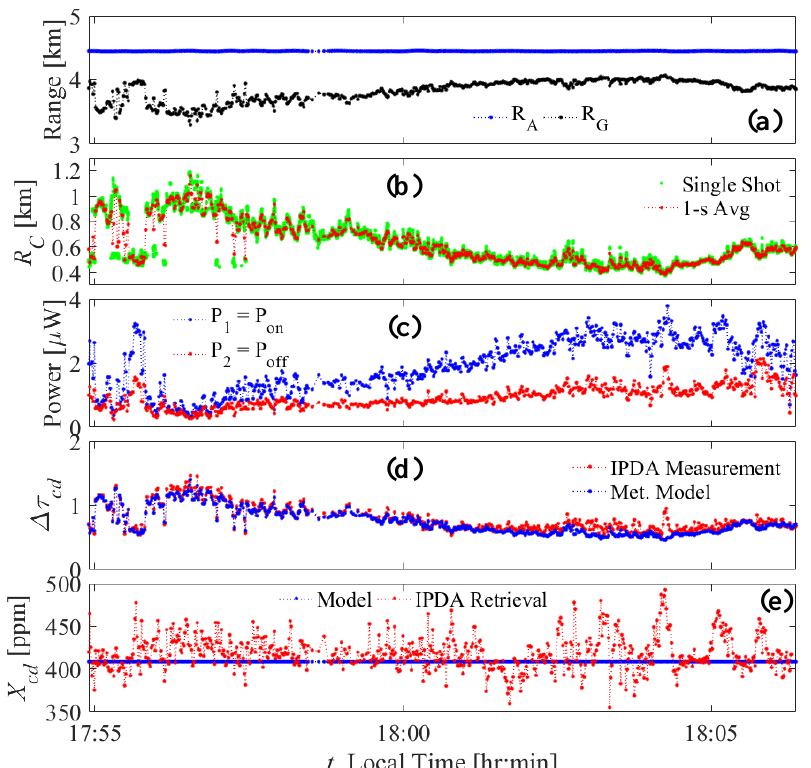
Figure 20. Airborne pulsed 2- µ m IPDA lidar measurement results using nadir thick clouds target. ( a ) GPS altitude and estimated target elevation, obtained using ( b ) IPDA column length measurements. Shot average of 1-s (50 shots) was applied to ( c ) on- and off-line return powers, set to pulse 1 and 2, respectively. ( d ) IPDA measured CO 2 differential optical depth as compared to modeled CO 2 differential optical depth derived using MGD of Figure 8. ( e ) Retrieved X cd , using IPDA measurement, as compared to model. Results are obtained using e-APD detection channel set to 3 V bias and 0.5 GHz on-line wavelength.